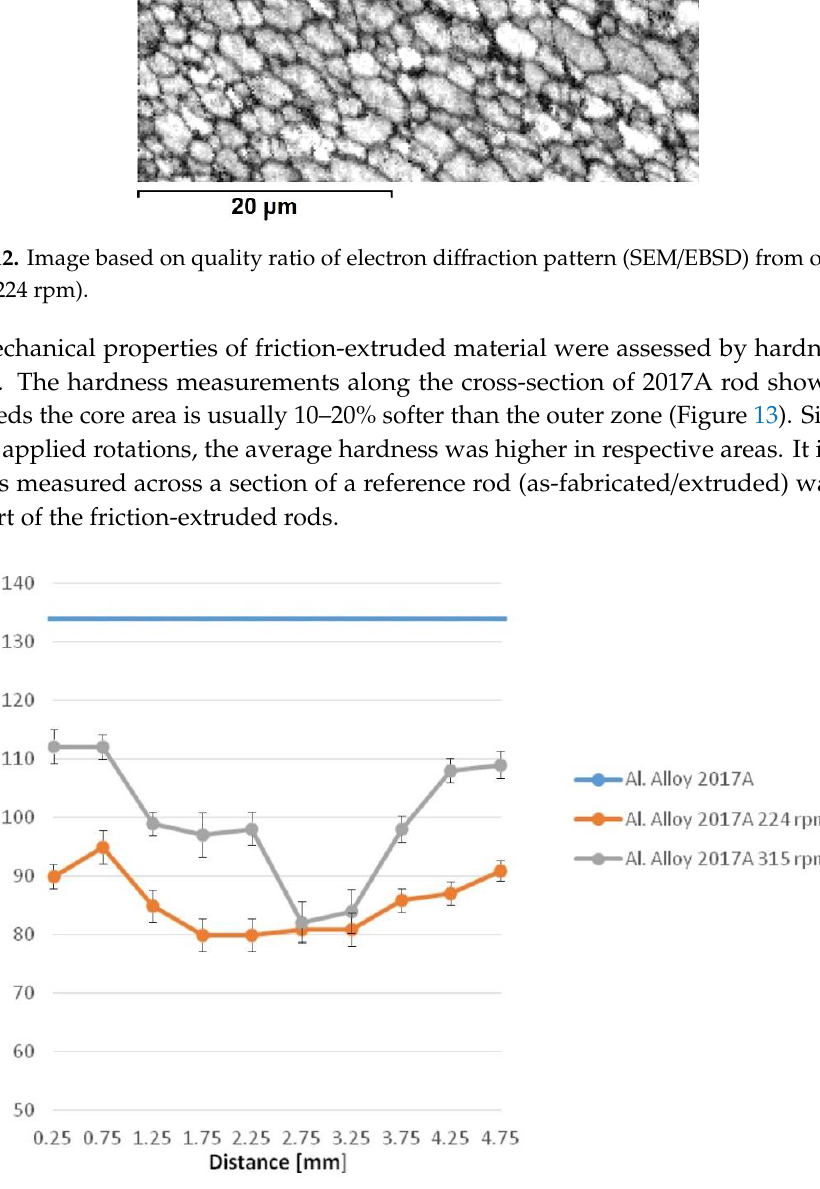
Figure 13. Hardness profiles measured on section of E and friction-extruded rods.